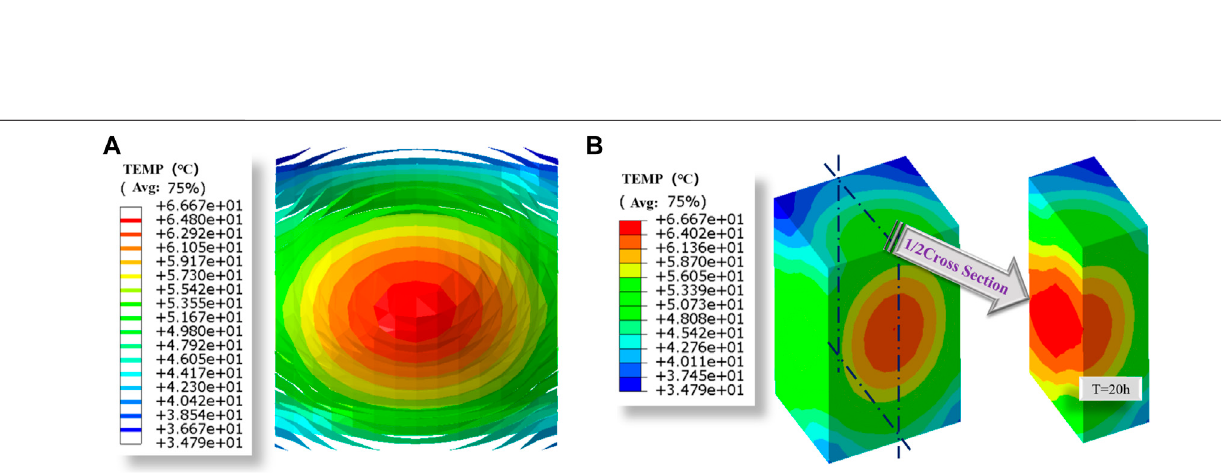
Frontiers in Materials |